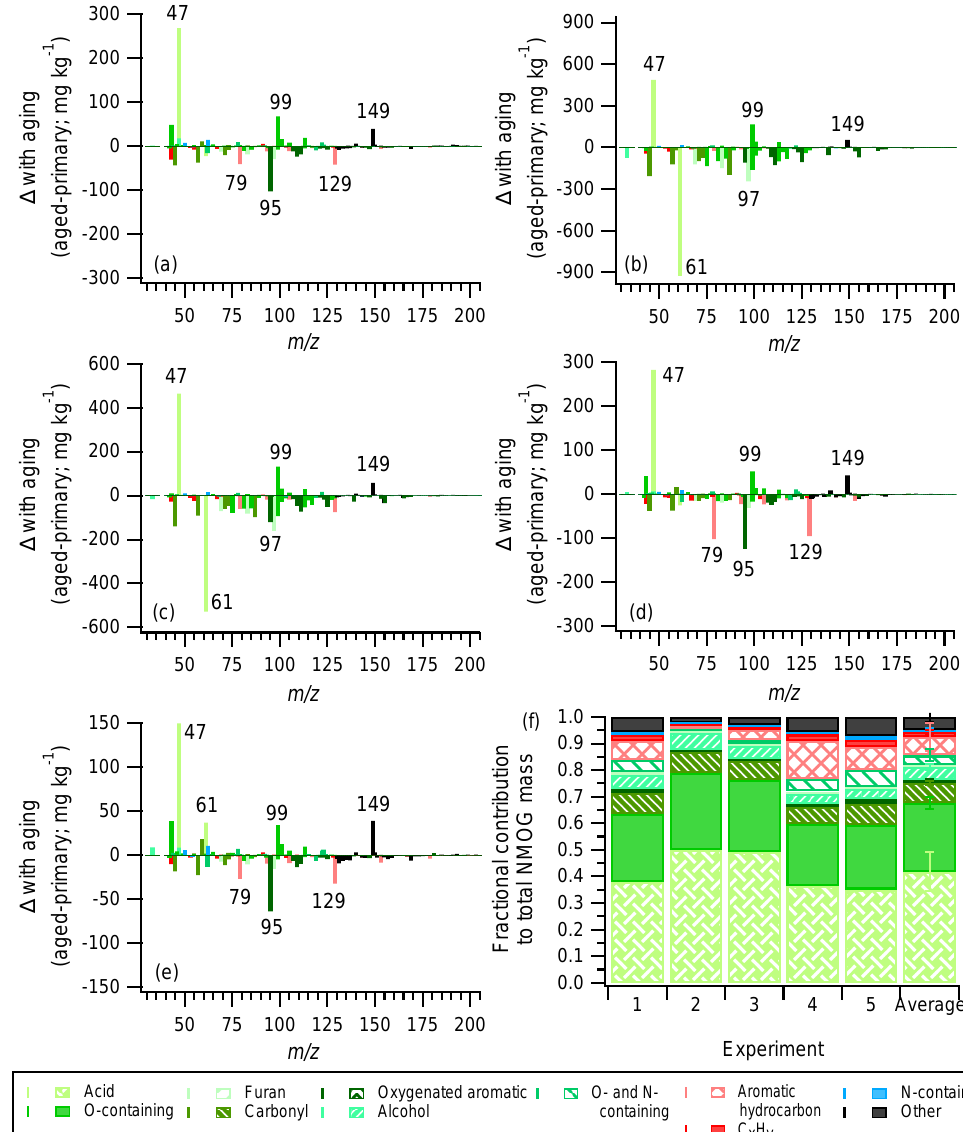
Figure 5. Absolute difference of aged and primary mass spectra for experiments 1–5 ( a – e ), where peaks less than zero decrease during ag- ing and peaks greater than zero increase during aging. Aged emissions correspond to an OH exposure of (4.5–5.5) × 10 7 moleccm − 3 h. ( a – e ) Labeled peaks correspond to [CH 2 O 2 + H] + ( m/z 47, formic acid), [C 2 H 4 O 2 + H] + ( m/z 61, acetic acid), [C 6 H 6 + H] + ( m/z 79, benzene), [C 6 H 6 O + H] + ( m/z 95, phenol), [C 5 H 4 O 2 + H] + ( m/z 97, furan-2-carbaldehyde), [C 4 H 2 O 3 + H] + ( m/z 99, maleic anhydride), [C 10 H 8 + H] + ( m/z 129, naphthalene) and [C 8 H 4 O 3 + H] + ( m/z 149, phthalic anhydride). The bars in (f) correspond to the fractional con- tribution of each category to the total NMOG EF at an OH exposure of (4.5–5.5) × 10 7 moleccm − 3 h for each experiment and the average of all experiments. Error bars correspond to one sample standard deviation of the